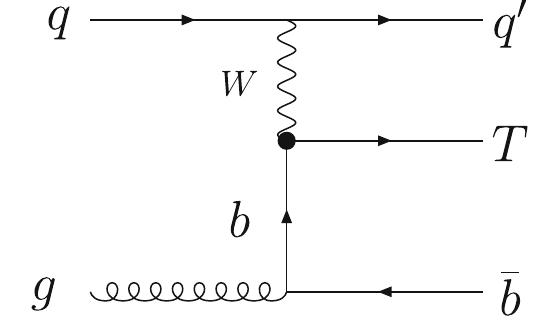
Fig. 1 The Feynman diagrams for the process pp → T ¯ b j